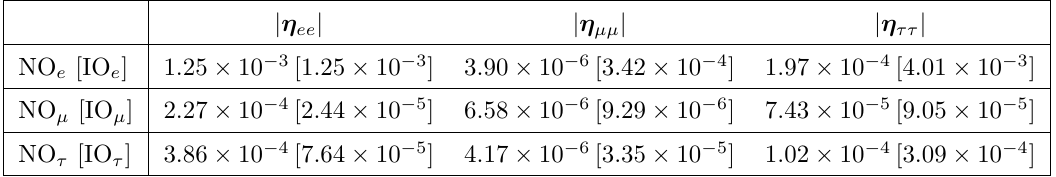
Table 9 . Upper bounds on V 2 | η | obtained in ref. [109], αα